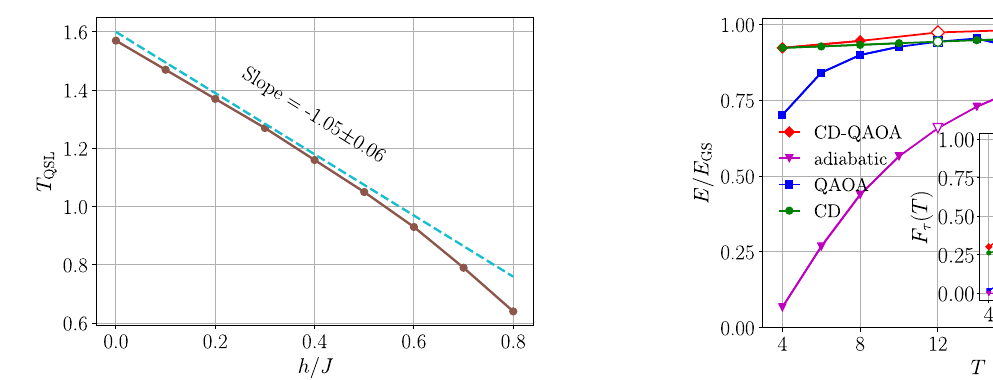
FIG. 7. Spin-1 Ising model: energy minimization and the FIG. 6. LMG model: quantum speed limit T as a function of QSL corresponding many-body fidelity (inset) against different pro- the transverse field h , for a target state in the ferromagnetic phase. π = 2 , which is the angle required to tocol duration T for four different optimization methods — CD- At h=J ¼ 0 , we have T QSL ¼ QAOA (red line), conventional QAOA (blue line), variational turn the z -polarized initial state into the x ferromagnet. For finite gauge potential (green line), and adiabatic evolution (magenta h=J , quantum fluctuations in the target ferromagnetic ground line). The empty symbols mark the duration for which the state decrease the angle required to transfer the population from evolution of physical quantities is shown in Fig. 24. The initial the initial state, which results in a smaller value of T . The QSL and target states are j ψ i i ¼ j ↓ (cid:4) (cid:4) (cid:4) ↓ i and j ψ i ¼ j ψ GS ð H Þi for dashed cyan line is a least-squares fit for small values of h=J , (cid:2) h =J ¼ 0 . 809 and h =J ¼ 0 . 9045 . The alternating unitaries for h Þ ¼ − h=J þ π = 2 þ O ð h 2 Þ . We z x suggesting the behavior T QSL ð H ; H conventional QAOA are generated by A 1 2 g QAOA ¼ f used N ¼ 501 spins. [cf. Eq. (6)]; for CD-QAOA, we extend this set using adiabatic H ; H ; Y; XY; gauge potential terms to A 1 2 CD − QAOA ¼ f YZ; X j Y; Y j Z g . The variational gauge potential in CD driving uses all five imaginary-valued gauge potentials f Y; XY; YZ; X j Y; Y j Z g . The CD- and adiabatic-driving simulations are both based on the smooth protocol function λ ð t Þ ¼ sin 2 ð π t= 2 T Þ , with a time- discretization step Δ t ¼ 0 . 2 . The value of q ¼ 20 , and the size of sequence space is j A jðj A j − 1 Þ q − 1 ≈ 10 15 . The system size is N ¼ 8 , where dim ð H Þ ¼ 498